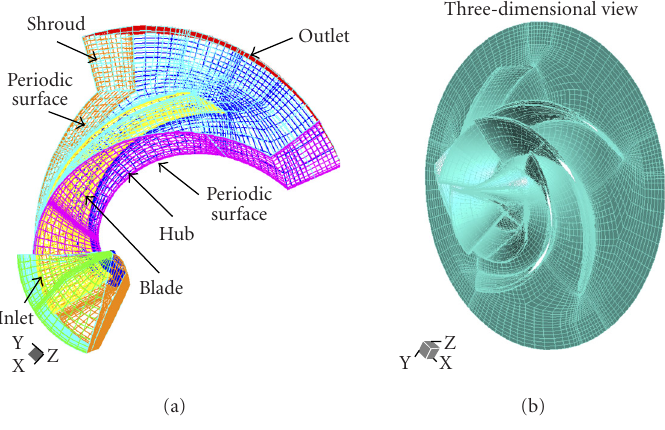
Figure 2: Impeller NS32: flow simulation domain and structured grid.